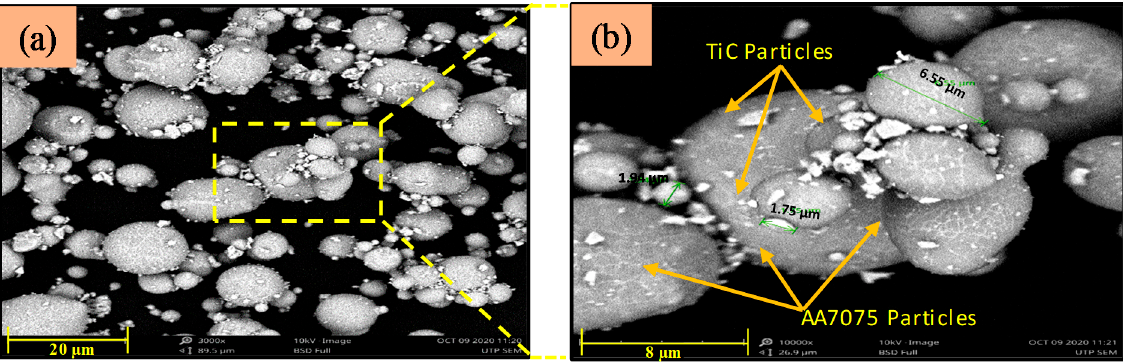
Figure 5. SEM images of the ( a ) 3 h-milled AL7075/4 wt.% TiC composite powder, and ( b ) magnified view of particle distribution for a selected region of ( a ).